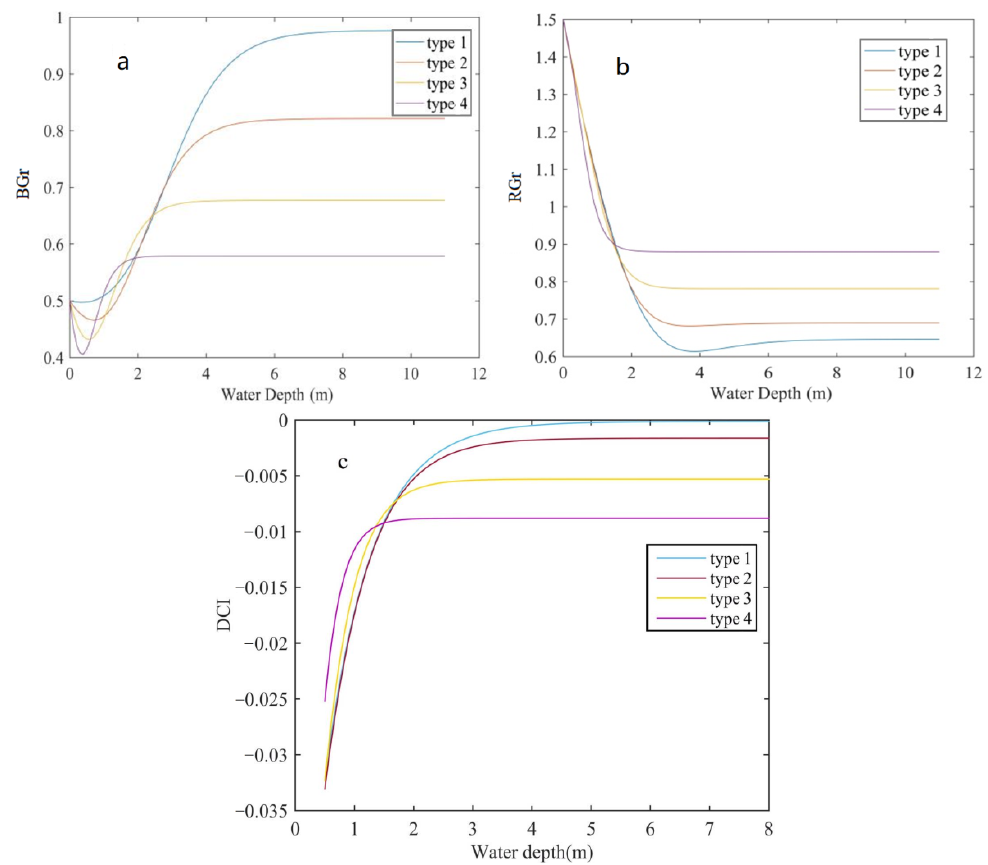
Figure 20. Plots of the ( a ) BGr, ( b ) RGr, and ( c ) DCI simulated by di ff erent types of waters versus water depths. Type 1, type 2, and type 3 represent ultraoligotrophic waters, oligotrophic waters, mesotrophic waters, and eutrophic waters, respectively.